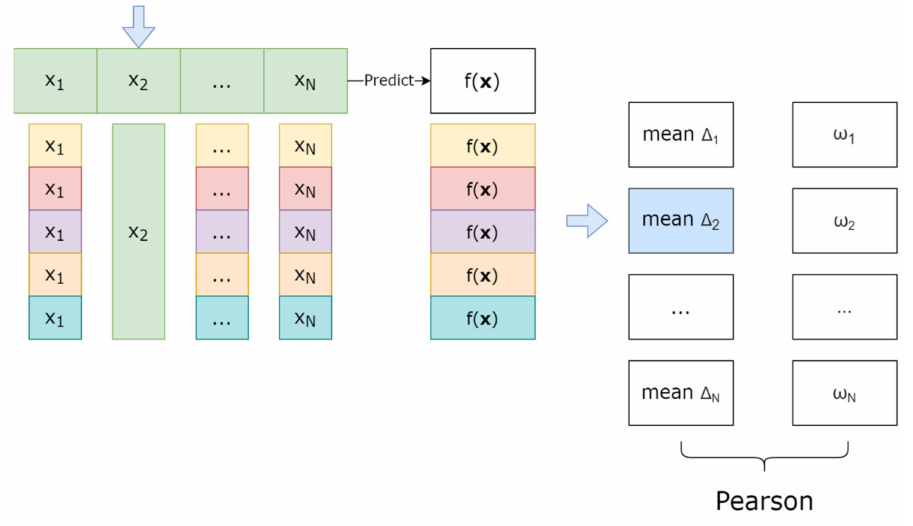
Figure 2. Scheme of the algorithm for calculating the faithfulness